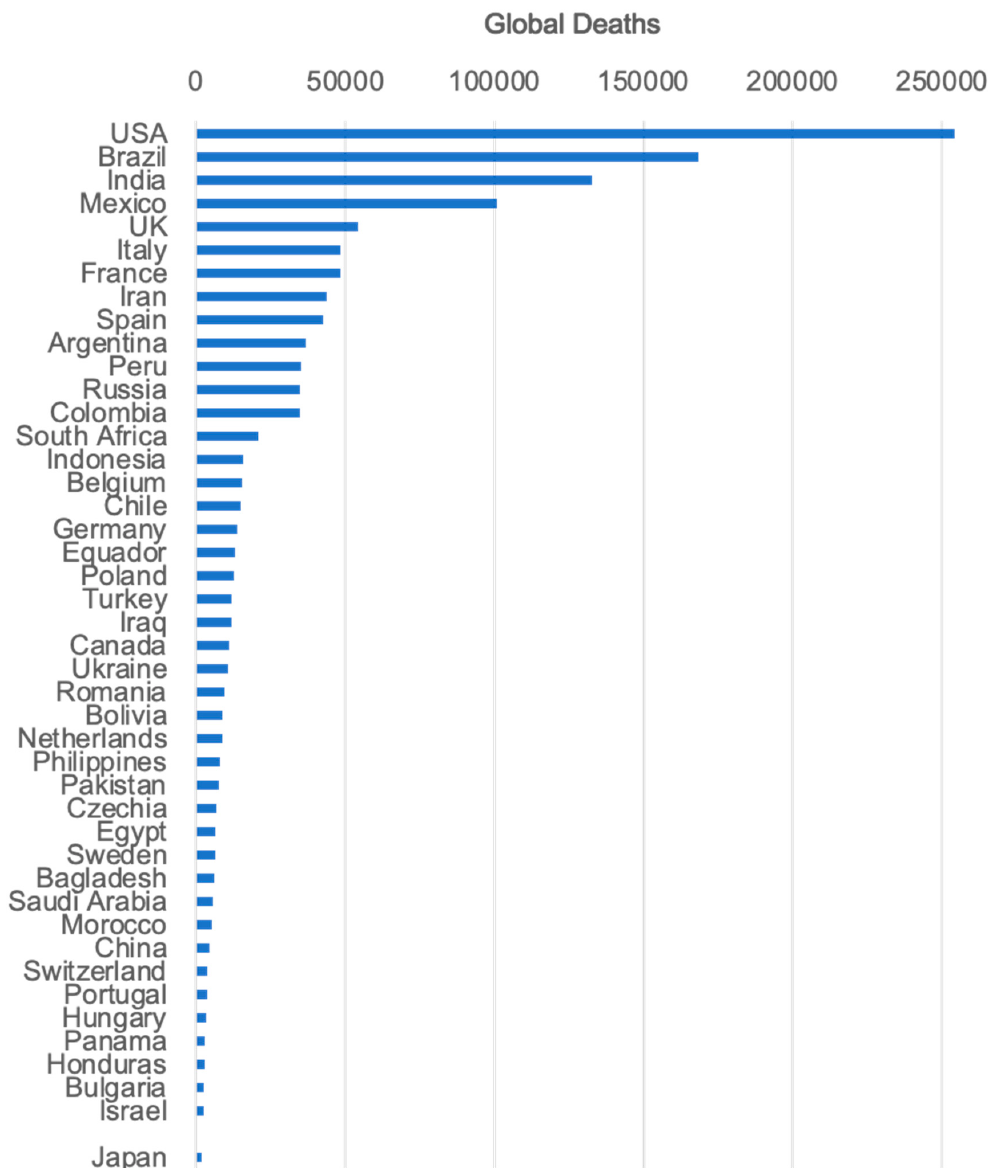
Figure 1. The number of global deaths due to the new coronavirus disease-2019 (COVID-19). The total number of global deaths due to COVID-19 was 1,372,182 as of 21 November 2020. The graph was generated from the COVID-19 Dashboard website by the Center for Systemics Science and Engineering at Johns Hopkins University (https: // systems.jhu.edu. Last updated on 21 November